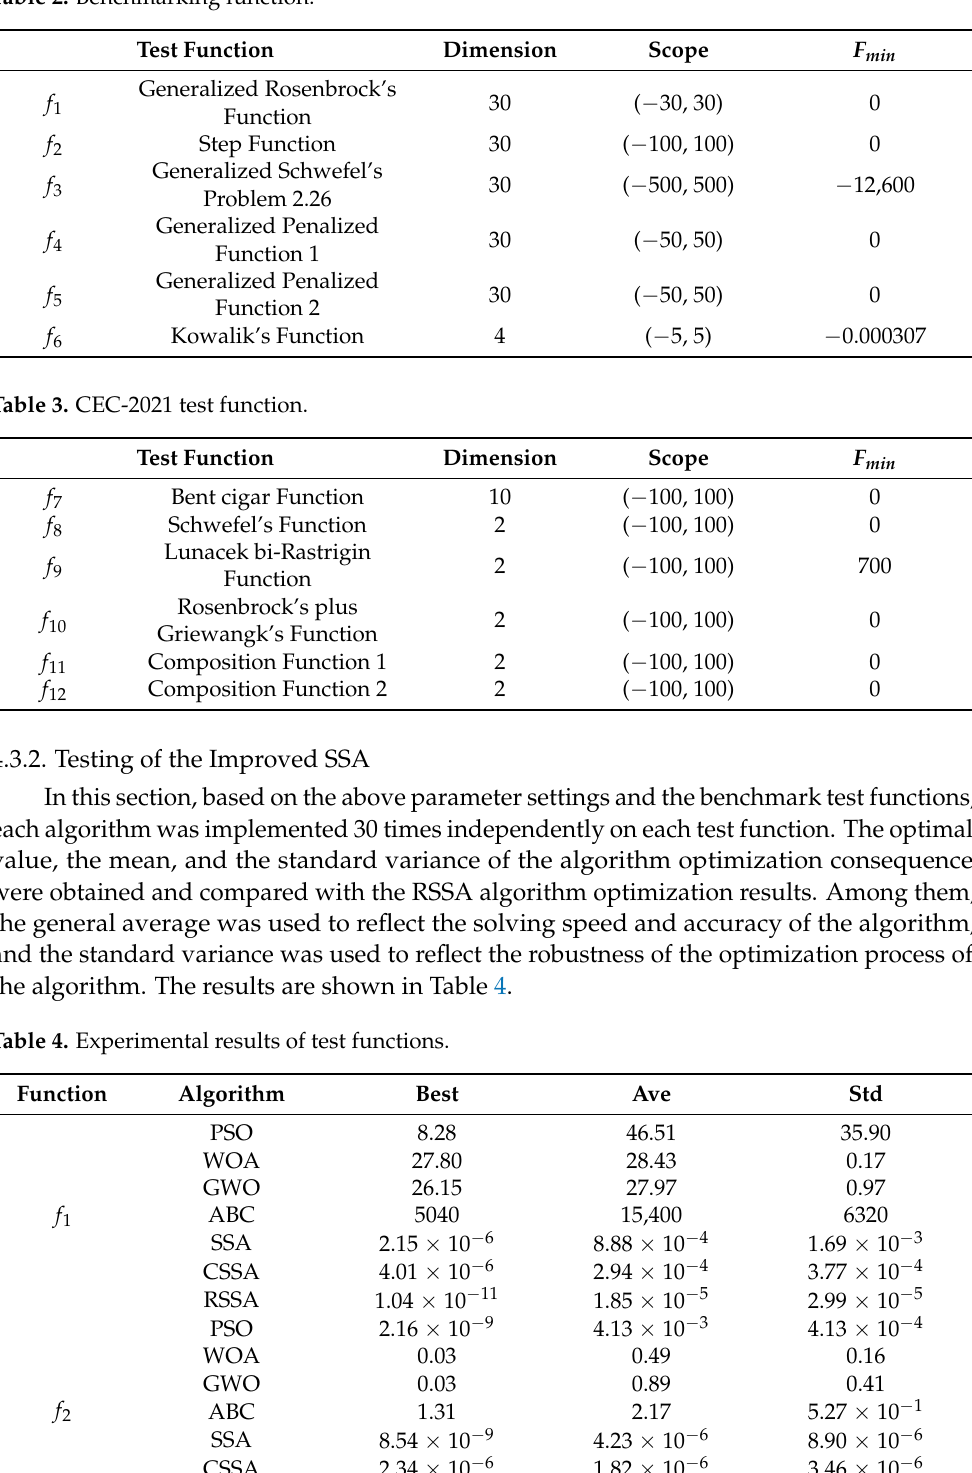
Table 2. Benchmarking function.